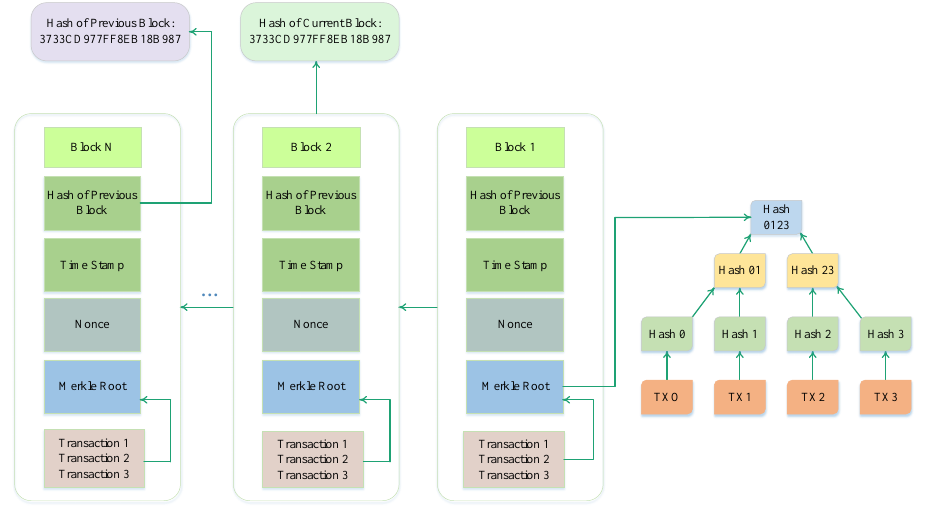
Figure 1. Basic Structure of